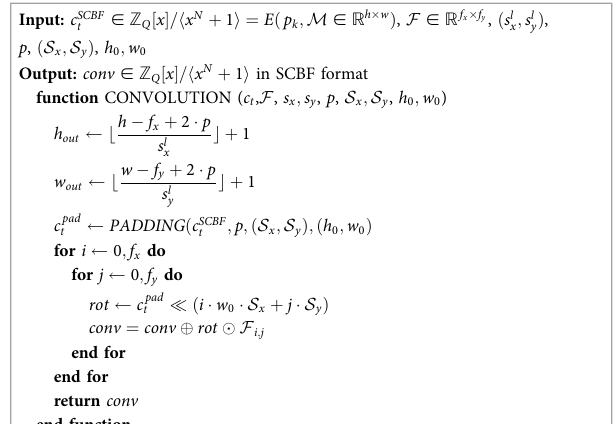
Algorithm 1 Streamlined 2D